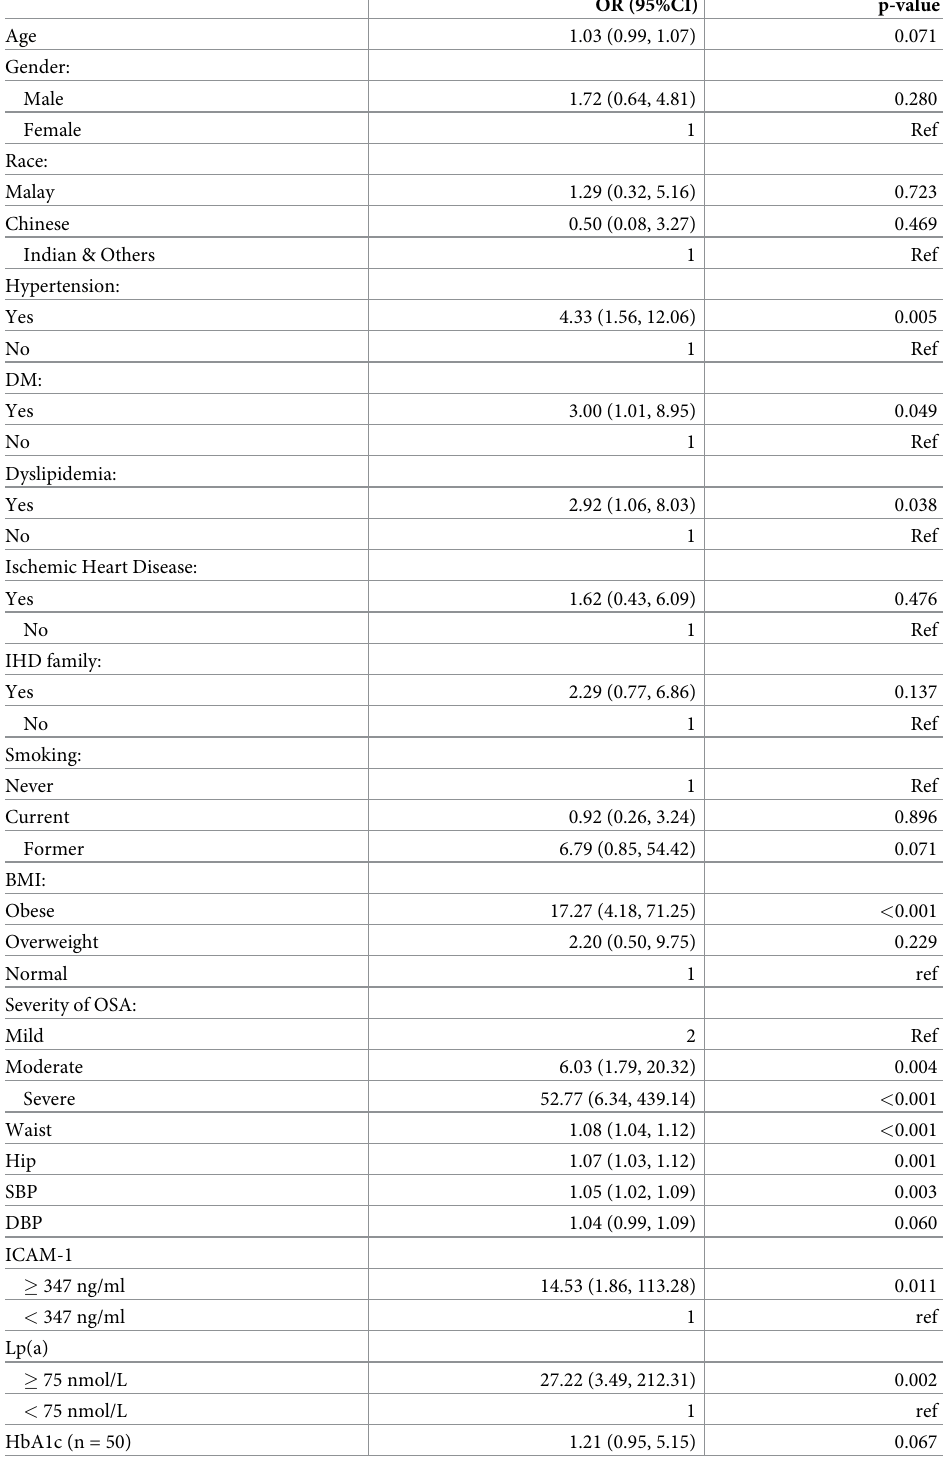
Table 5. Analysis of associated factors for NAFLD in OSA